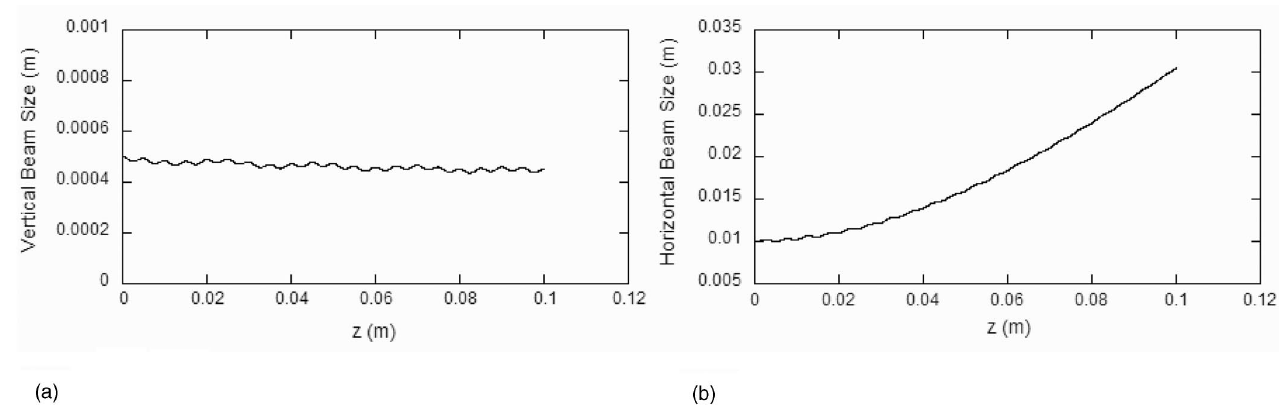
FIG. 3. (a) Vertical beam size, for the nominal natural focusing case (emittance of 1.4 mm, 20 A, 0.266 T wiggler focusing field). (b) Horizontal beam size.